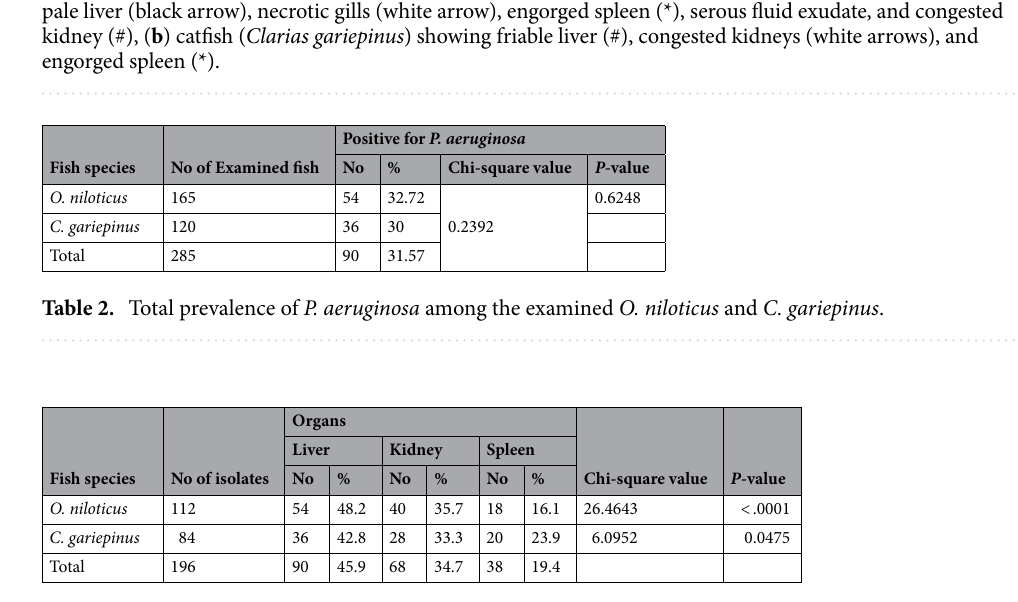
Table 3. Prevalence of P. aeruginosa in different organs of naturally infected O. niloticus and C. gariepinus